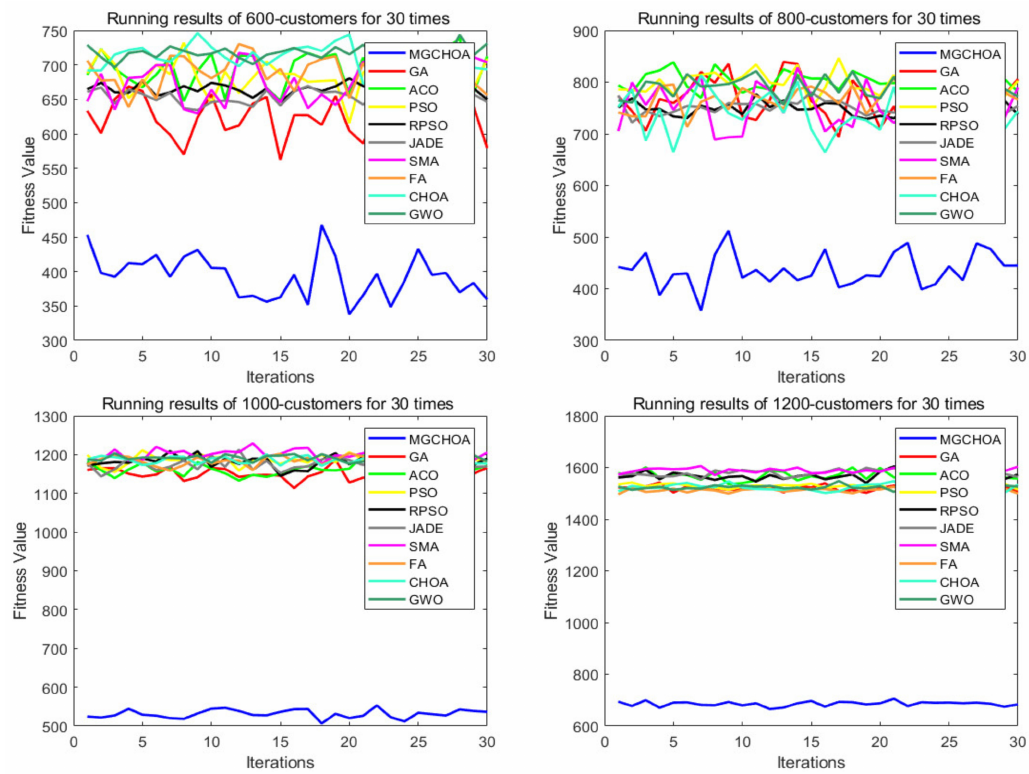
Figure 16. The results of 30 algorithm